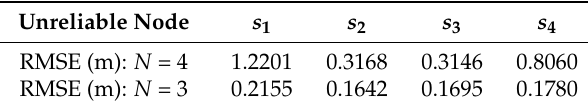
Table 1. RMSE for different numbers of nodes.